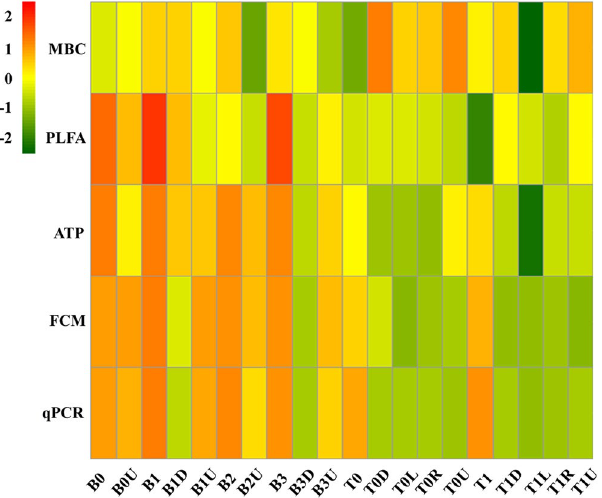
Figure 3. Comparison of the bacterial cell numbers derived from different measurements. Differences were visualized by heatmap. FCM: flow cytometry, ATP: adenosine tri-phosphate, qPCR: quantitative PCR, PLFA: phospholipid fatty acids, MBC: microbial biomass Carbon.